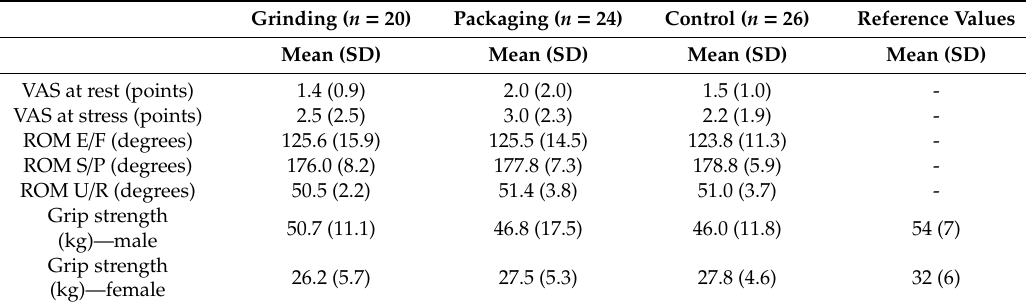
Table 10. Clinical data: continuous parameters.